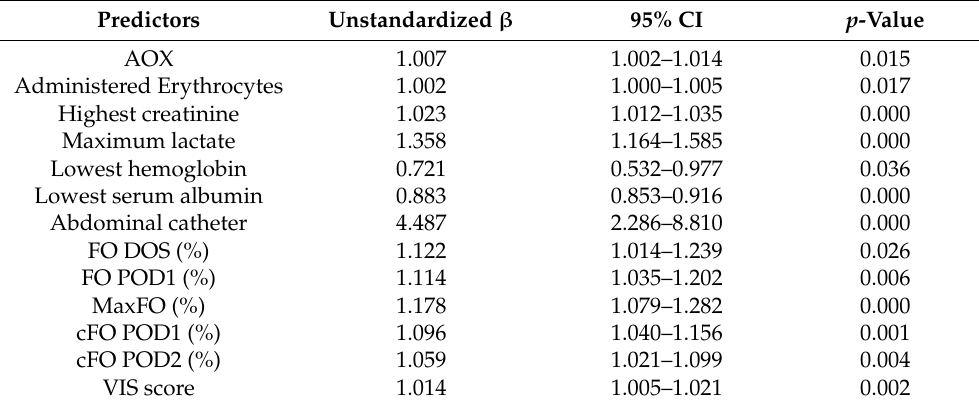
Table 2. Univariate predictors of PICU